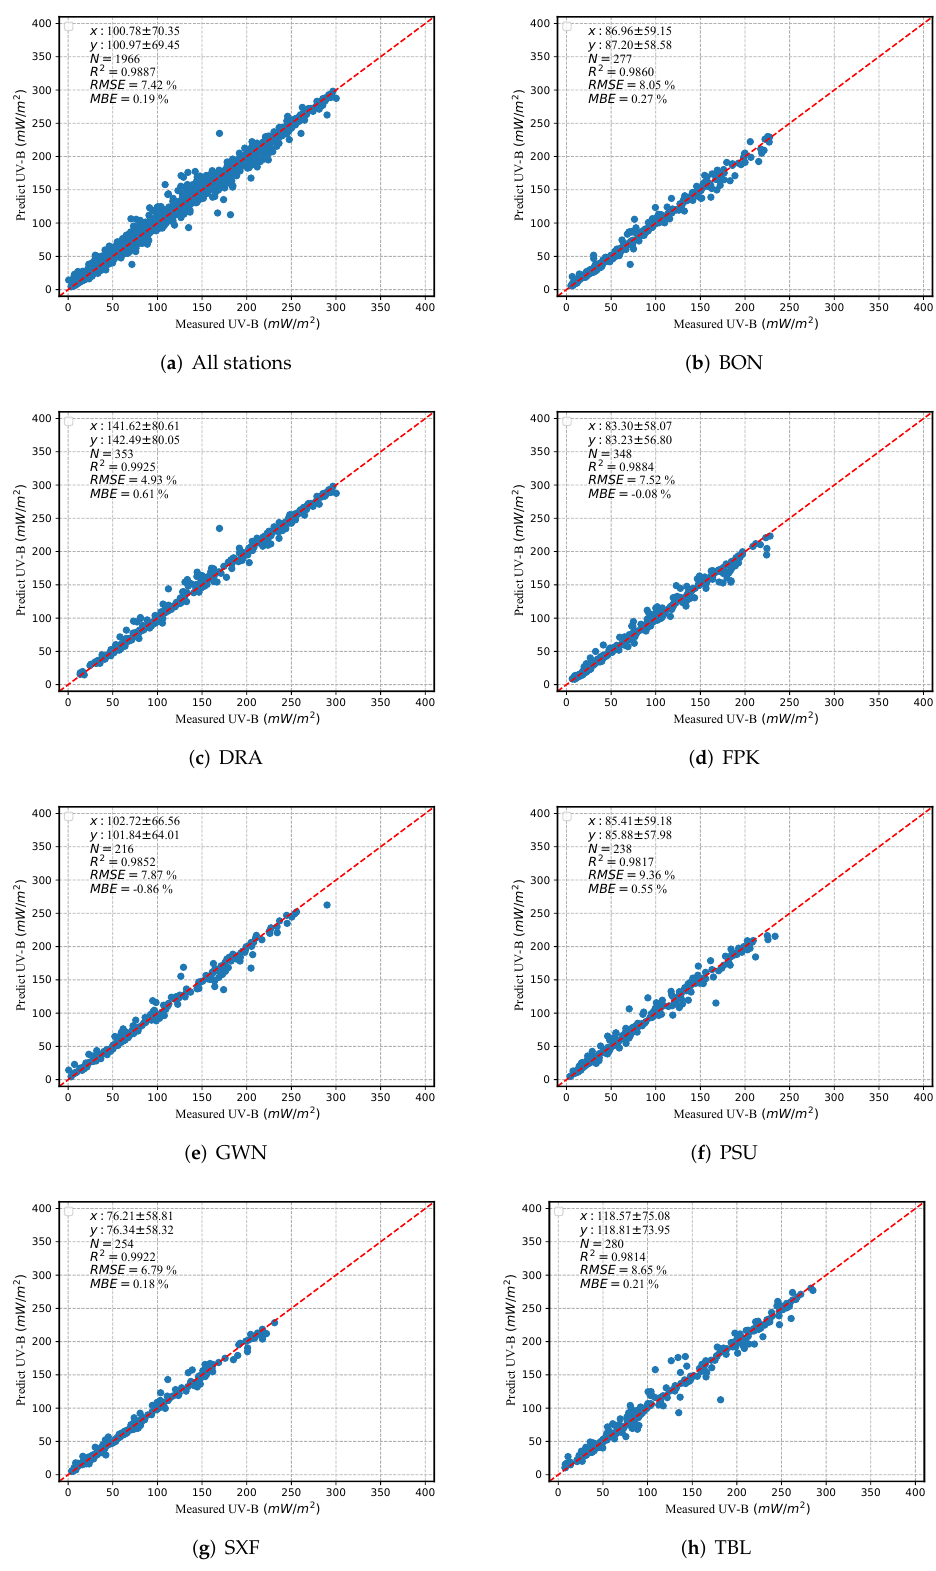
Figure 8. Comparison between measured and estimated erythemal UV-B on SURFRAD test data: ( a ) shows the evaluation results of the entire SURFRAD test set, while ( b – h ) show the results of one station in the SURFRAD test